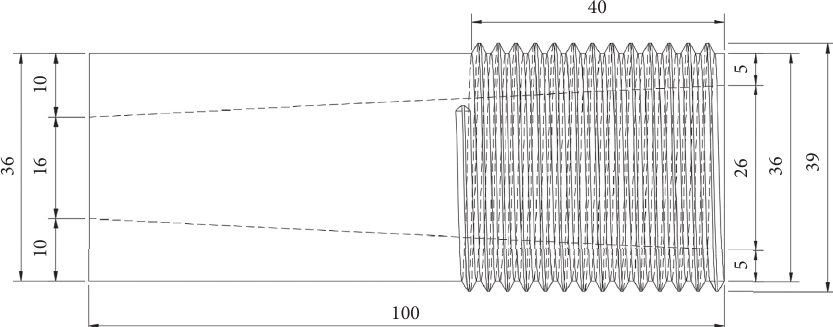
Figure 9: Dimension of anchor socket (unit: